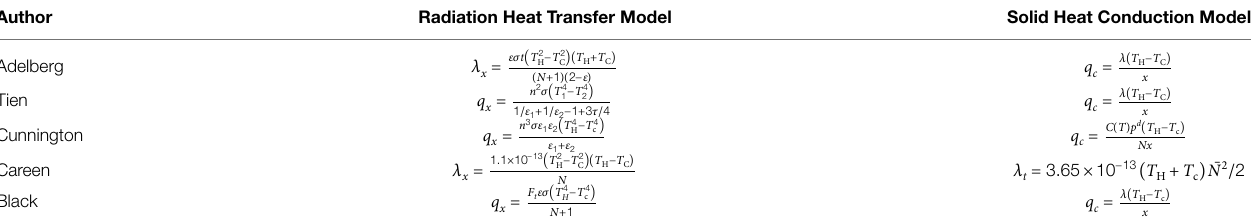
TABLE 2 | Calculation model of multilayer heat transfer performance.